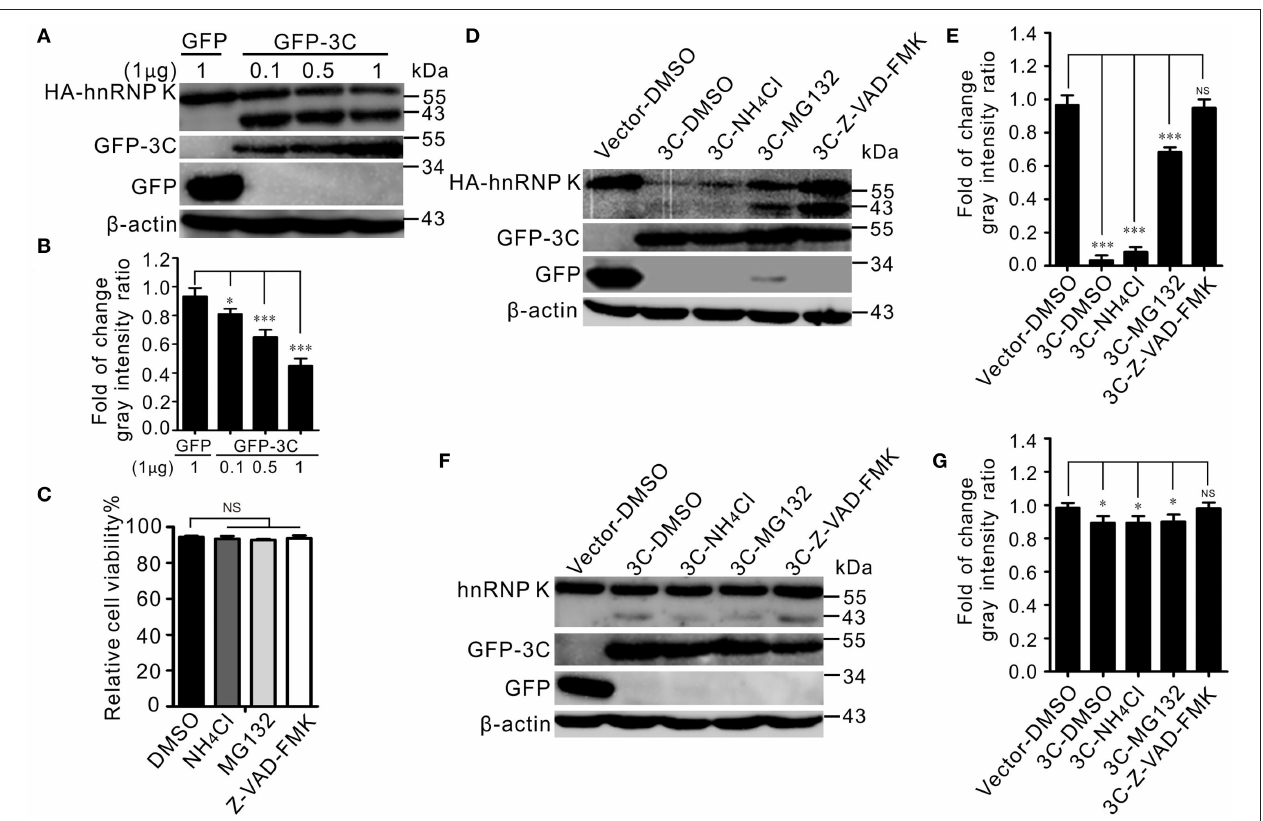
FIGURE 4 | SVV 3C pro meditated hnRNP K degradation via its enzyme activity, through the caspase pathway. (A) BHK-21 cells in six-well plates were cotransfected with 1 µ g HA-hnRNP K and 0.1, 0.5, and 1 µ g GFP-3C or empty vector, respectively. The cell lysates were subjected to Western blotting at 24 hpt. (B) The ratios of HA-hnRNP K normalized against β -actin of three independent experiments of (A) (* P < 0.05; *** P < 0.001). Graphs of quantification analyzed with Image J. Data are represented by mean ± SD. (C) The viability of BHK-21 cells was analyzed using CCK-8 assay after treatment with chemical reagents. Error bars indicate the mean ± SD of three independent experiments (NS, not significant). (D) BHK-21 cells in six-well plates were cotransfected with HA-hnRNP K and GFP empty vector, or GFP-3C. At 10 hpt, cells were treated with DMSO, Z-VAD-FMK (50 µ M), MG132 (10 µ M), and NH 4 Cl (10mM). The cell lysates were subjected to Western blotting at 24 hpt. (E) The ratios of HA-hnRNP K normalized against β -actin of three independent experiments of (D) (* P < 0.05; *** P < 0.001). Graphs of quantification analyzed with Image J. Data are represented by mean ± SD. (F) BHK-21 cells in six-well plates were transfected GFP empty vector, or GFP-3C. At 10 hpt, cells were treated with DMSO, Z-VAD-FMK (50 µ M), MG132 (10 µ M), and NH 4 Cl (10mM). The cell lysates were subjected to Western blotting at 24 hpt. (G) The ratios of hnRNP K normalized against β -actin of three independent experiments of (F) (* P < 0.05; *** P < 0.001). Graphs of quantification analyzed with Image J. Data are represented by mean ±